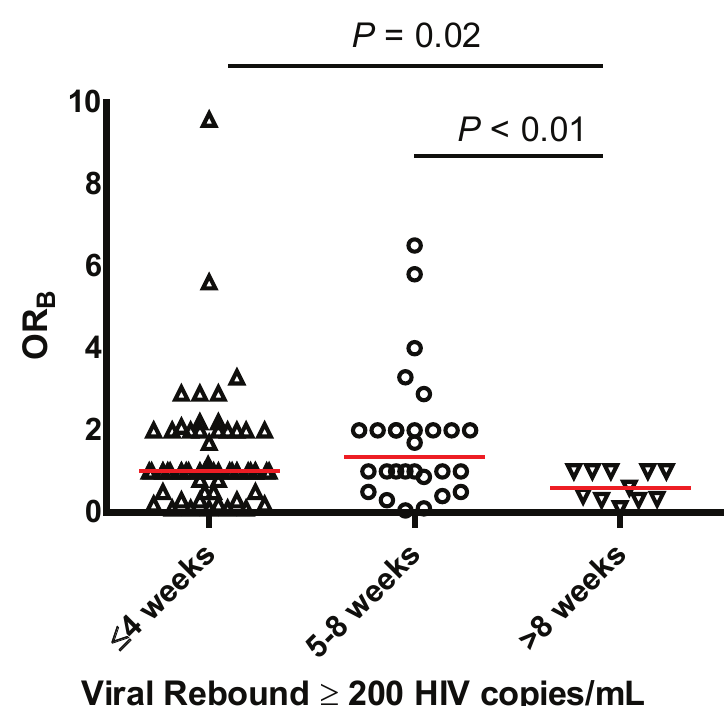
Figure 2. Association between OR and timing of viral rebound. OR represents the protective status at B B the HLA-B locus and is calculated for each individual by multiplying the OR estimate of HIV non-control for each of the 2 alleles carried by that